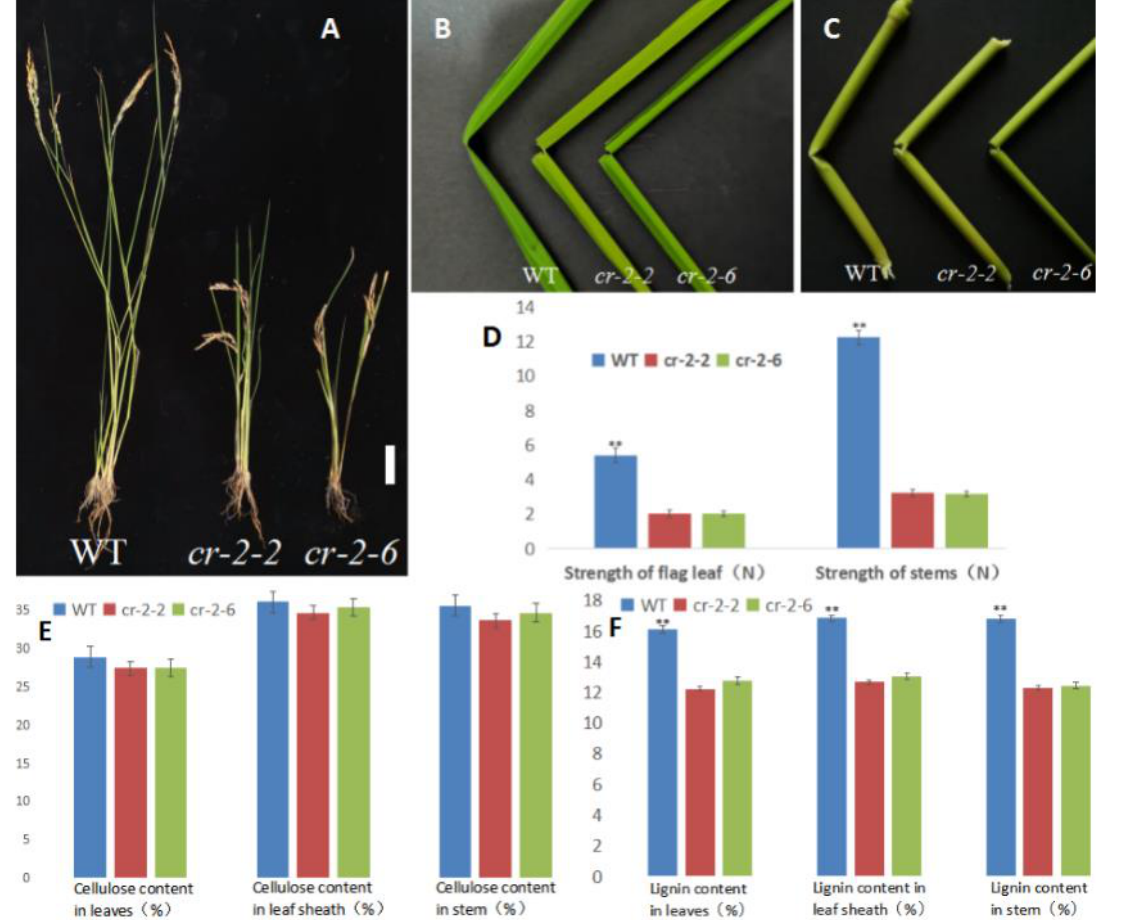
Figure 3. Phenotypes of wild-type and candidate gene knockout rice plants. ( A ) Wild-type, mutant cr-2-2 , and mutant cr-2-6 plants. Bar = 10 cm; ( B , C ) fracture points of flag leaves ( B ) and internodes ( C ) of wild-type, mutant cr-2-2 , and mutant cr-2-6 plants. ( D ) Comparison of the mechanical strength of WT, mutant cr-2-2 , and mutant cr-2-6 plants. **, significantly different at p < 0.01. ( E , F ) Cellulose contents ( E ) and lignin contents ( F ) of wild-type Pingtangheinuo and mutant cr-2-2 and cr-2-6 plants. **, significantly different at p < 0.01.